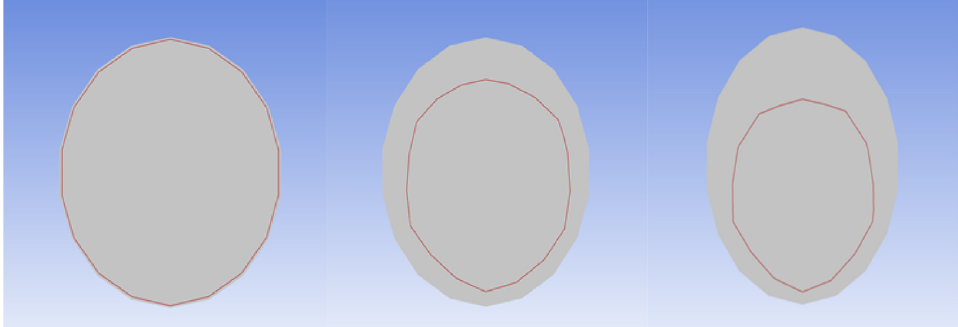
Figure 20. The change in isotherms along the flow